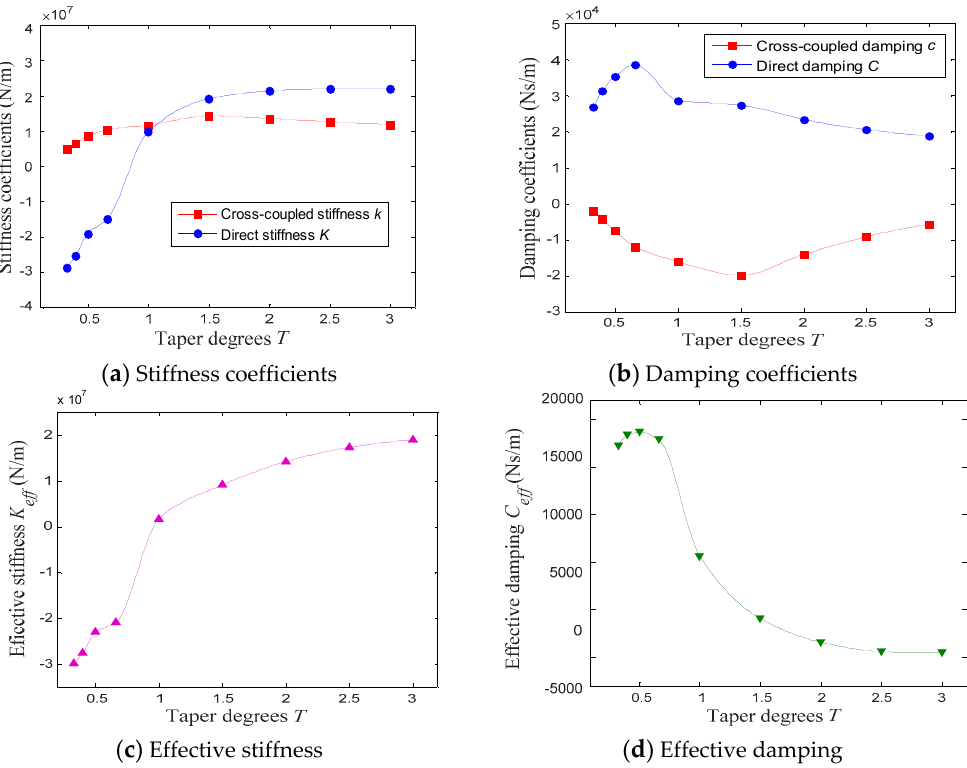
Figure 13. The influence of taper degrees on rotor-dynamic coefficients ( a – d ) of hole-pattern damper seals, where P inlet = 7 MPa, P outlet = 3.15 MPa, RS = 20,200 r/min, and T inlet = 17.4 °C.